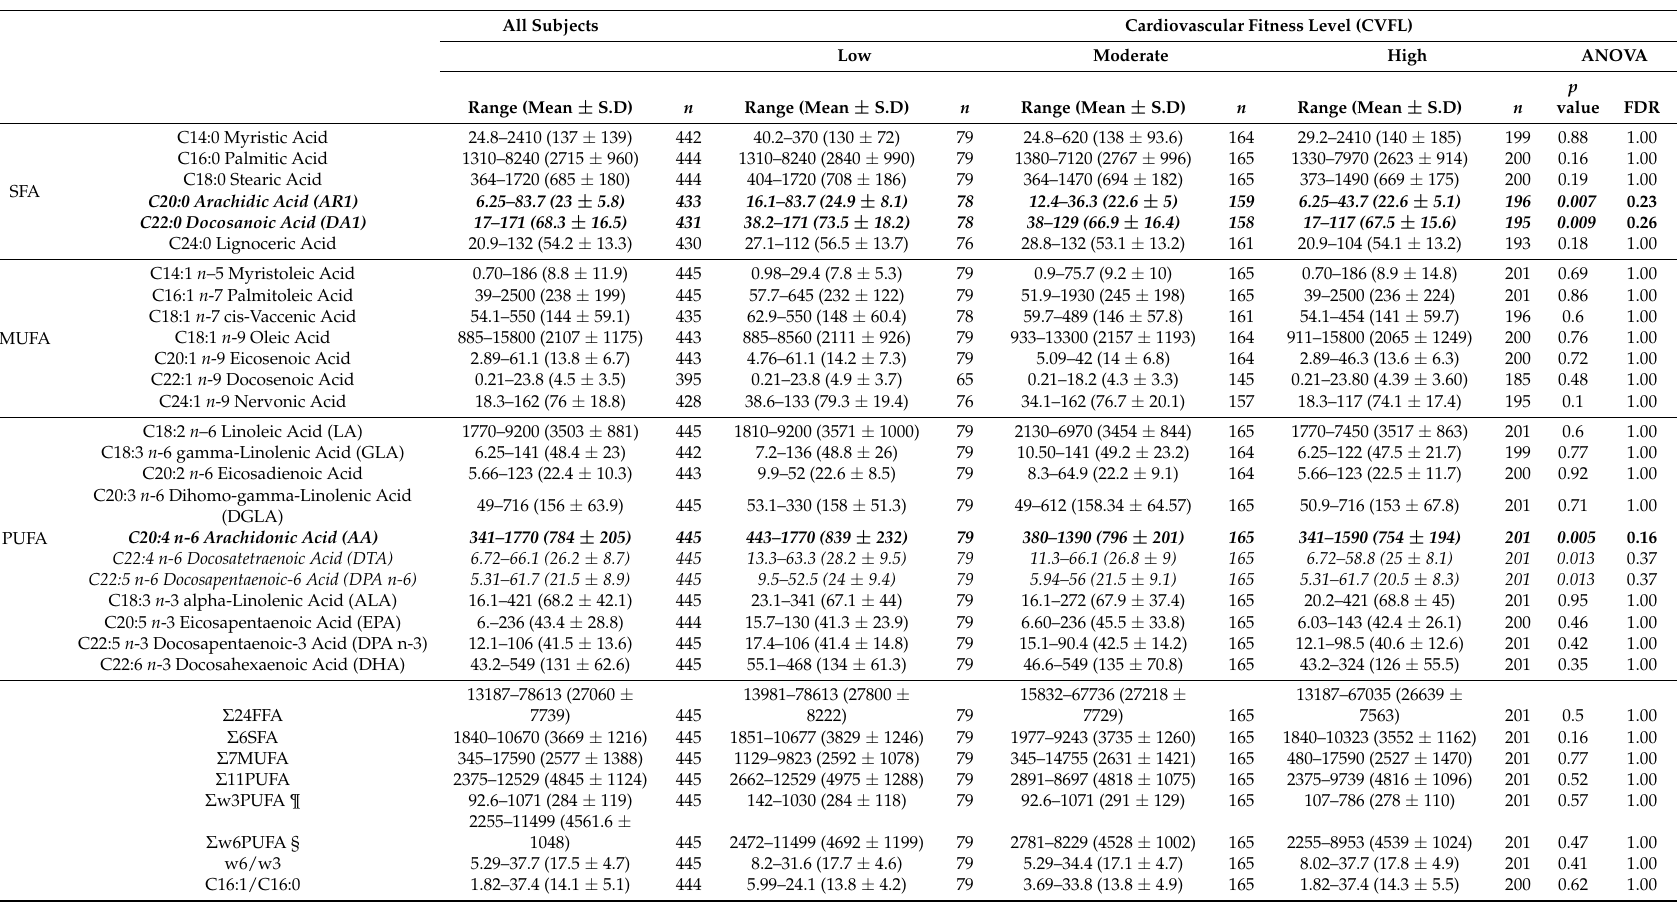
Table 2. Twenty-four Fatty Acid Levels in Fasting Plasma and 8 derivative variables of interest: overall and stratified by cardiovascular fitness